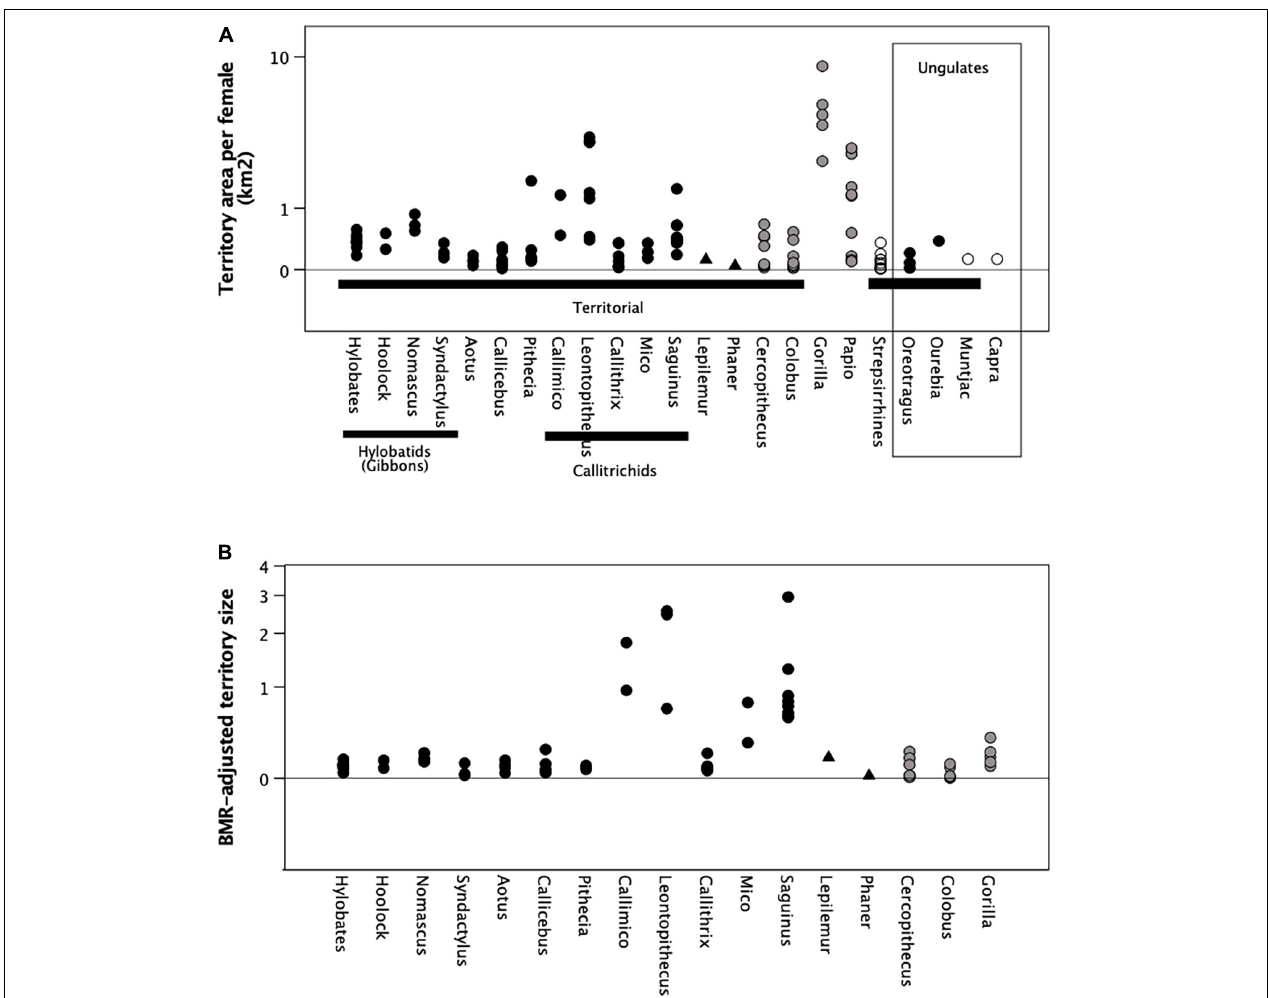
FIGURE 1 | (A) Observed absolute territory size per adult female (km 2 ) and (B) Relative territory size per female adjusted for female metabolic weight (km 2 /kg 0 . 75 ). The main higher taxonomic groupings are indicated at the base of panel (A) . Territorial taxa are indicated by the black bar across the lower part of the graph. Filled symbols: social or dispersed monogamous groups; grey symbols: stable polygynous groups; unfilled symbols: roving male polygyny. Ungulate genera are enclosed in the box on the right; all other genera are primates. Y-axis is log 10